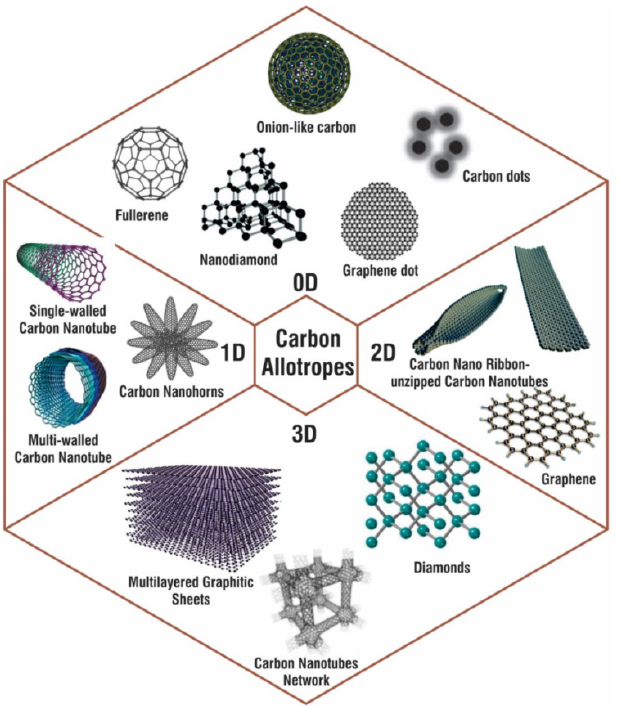
Figure 2. Various carbon allotropes with examples for 0D, 1D, 2D, and 3D carbon nanostructures. Diagram taken from [39].